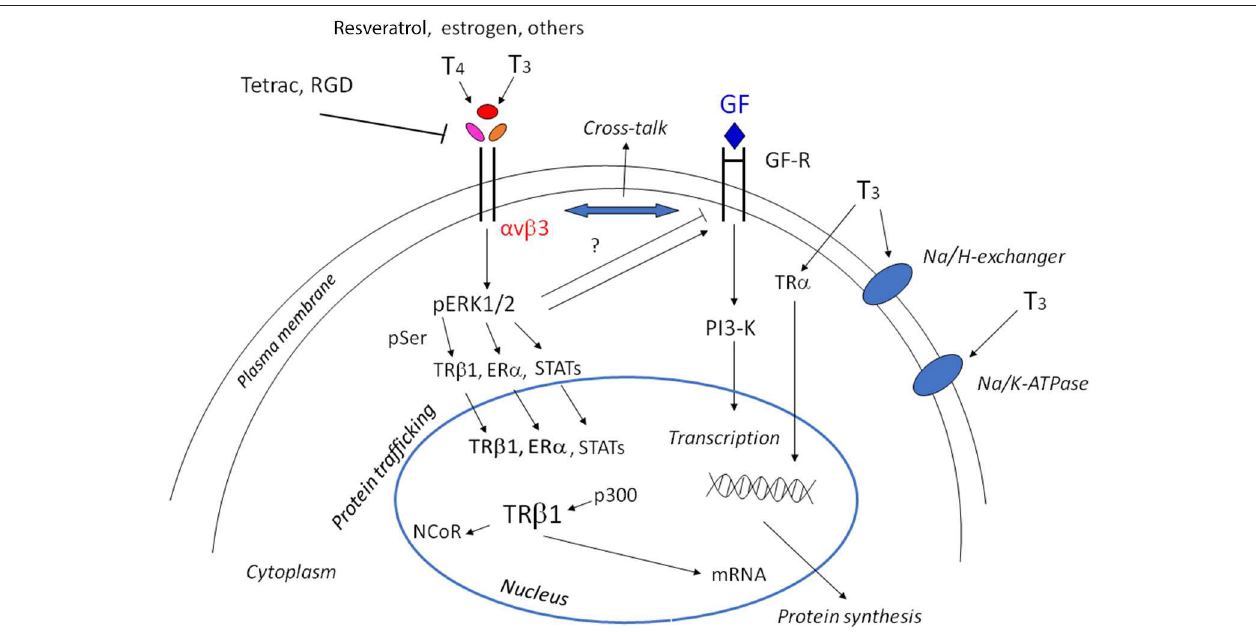
FIGURE 1 | Scheme of non-genomic and genomic actions of thyroid hormones. Non-genomic actions start at the integrin α v β 3, through MAPK/ERK1/2 they may go to the cytoplasm and nucleus to modulate gene expression. The shuttling of the α v monomer to the nucleus is not shown for the sake of simplicity. The cross-talk of thyroid hormones with growth factors is indicated by the double arrow and can be modulated by ERK1/2 activation. The modulation of the membrane Na/K-ATPase pump, either in activation or inhibition depending on the cell type and context, and activation of the Na/H exchanger is also indicated. In the nucleus, interaction of T3 gives rise to the shedding of the corepressor and the interaction with coactivators. Downstream of the activation of TR β 1, Er α , STATS there is the activation of tumor cell proliferation, angiogenesis, and growth factors (GF), but also cytokines through